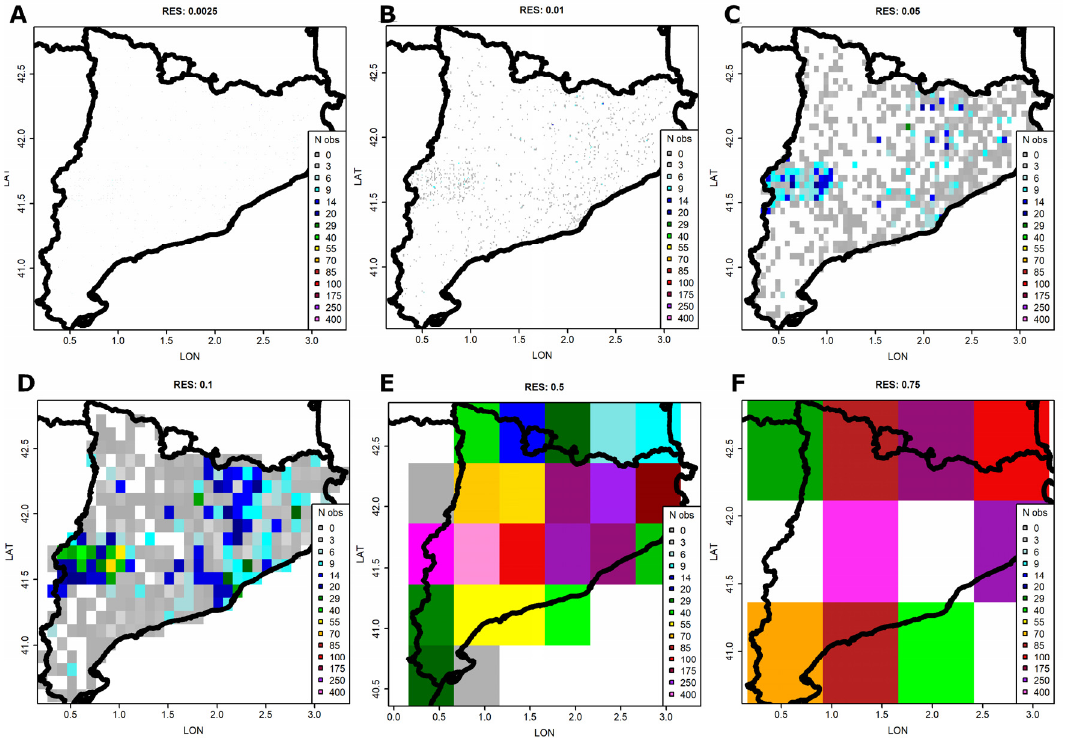
Figure 4. Raster of the number of the total observations registered per pixel with different spatial resolutions (0.0025° × 0.0025° — panel ( A ), 0.01° × 0.01° — panel ( B ), 0.05° × 0.05° — panel ( C ), 0.1° × 0.1° — panel ( D ), 0.5° × 0.5° — panel ( E ), and 0.75° × 0.75° — panel ( F )), for the period 2004 to 2022.